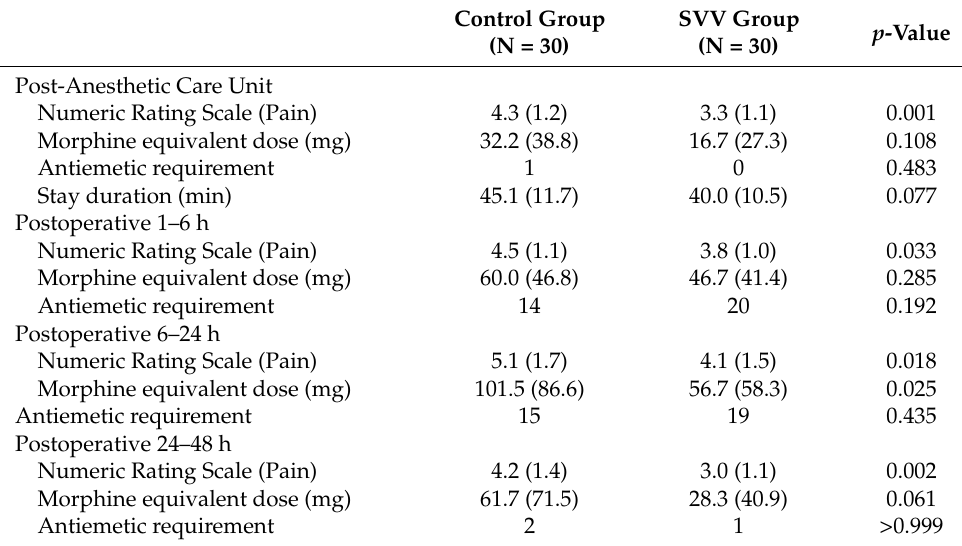
Table 3. Postoperative pain and